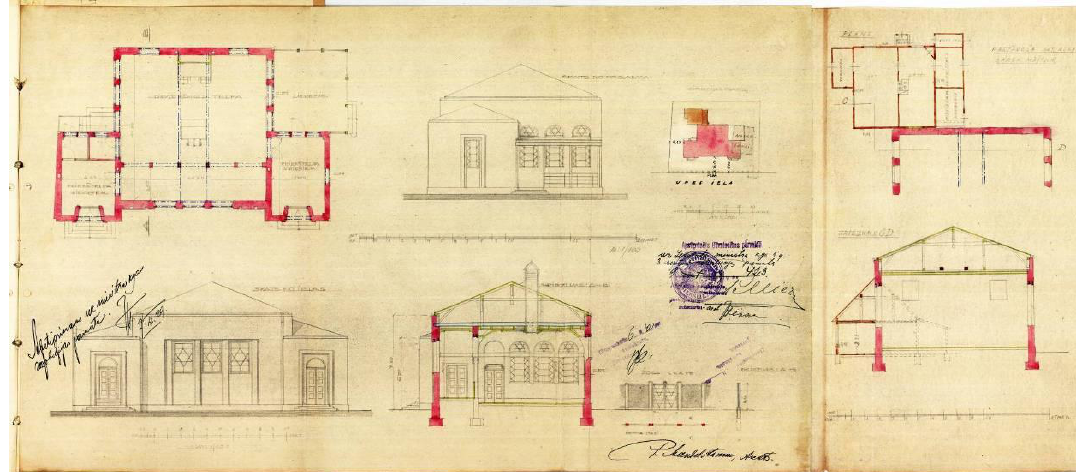
Figure 10. Design for a synagogue in Bulduri by Paul Mandelstamm, 1929, brick alternative. LNA LVVA. Used by permission.